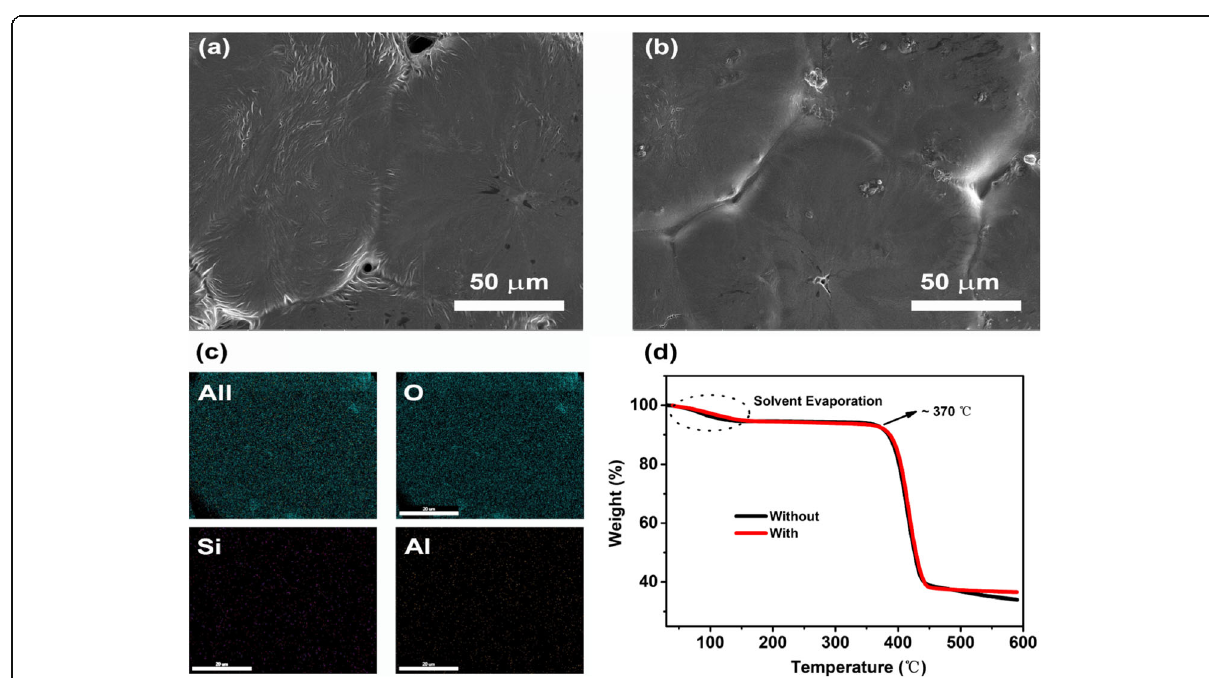
Fig. 2 SEM images of SPEs without ( a ) and with ( b ) montmorillonite doping. c The element mapping of SPEs with modification of montmorillonite. d TGA curve of SPEs from 30 to 600 °C at a rate of 10 °C min − 1